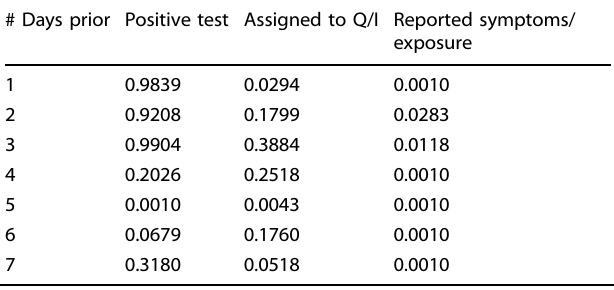
Table 2. Node base risk scores learned by the node risk prediction model. Higher scores indicate a greater transmission risk. To predict high-risk students, each student ’ s base risk score ( P 0 ) is propagated to neighboring nodes via Eq. 1. Q/I represents quarantine/isolation.